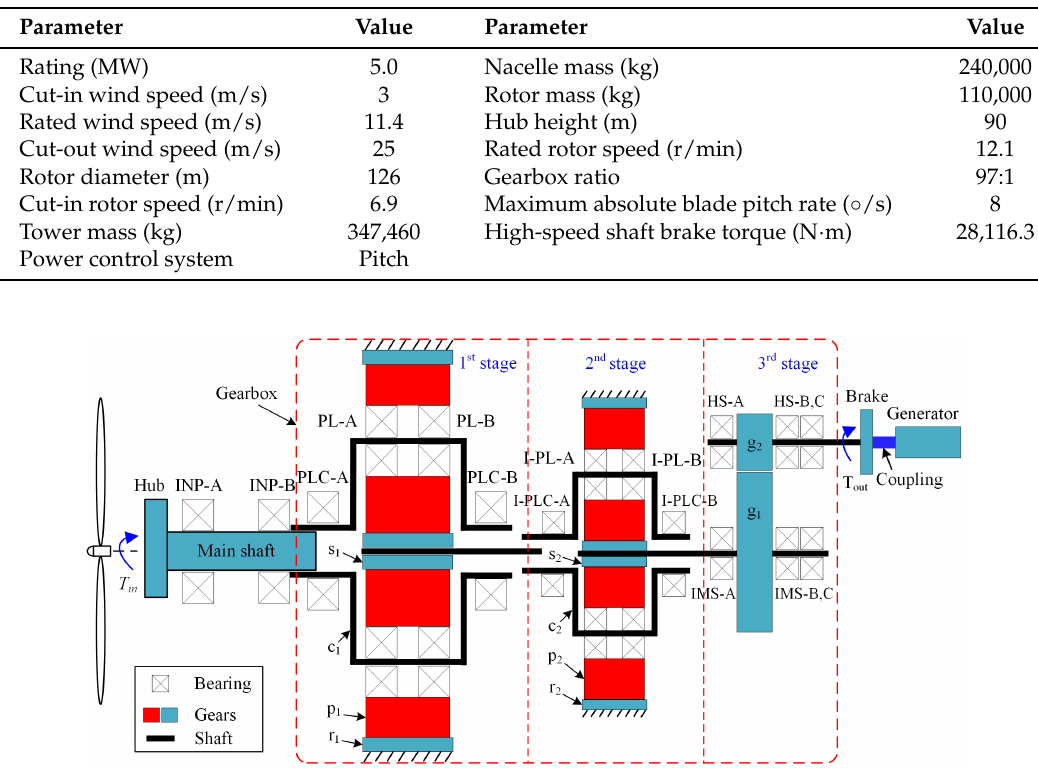
Figure 2. Schematic layout of 5MW wind turbine